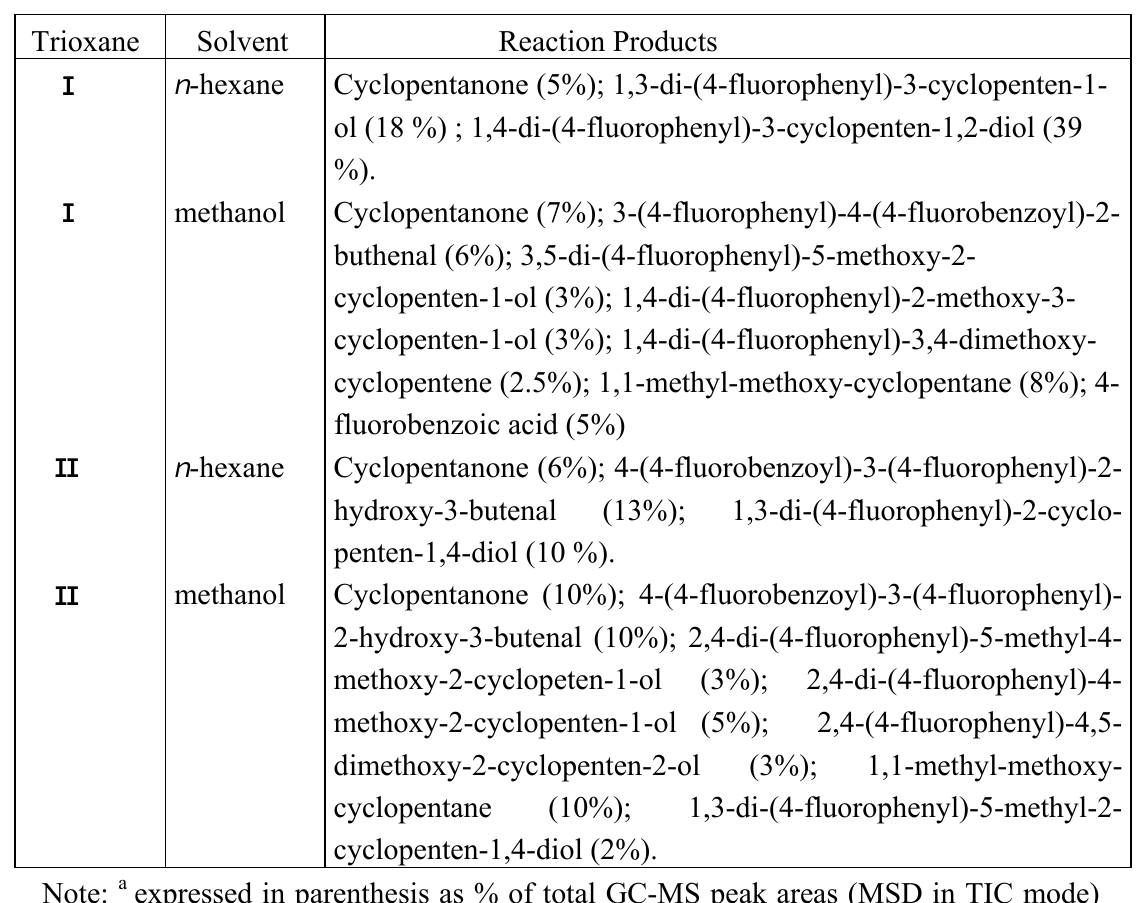
Table III . Products Molar Yields a Arising from the Thermolysis of I and II in Different